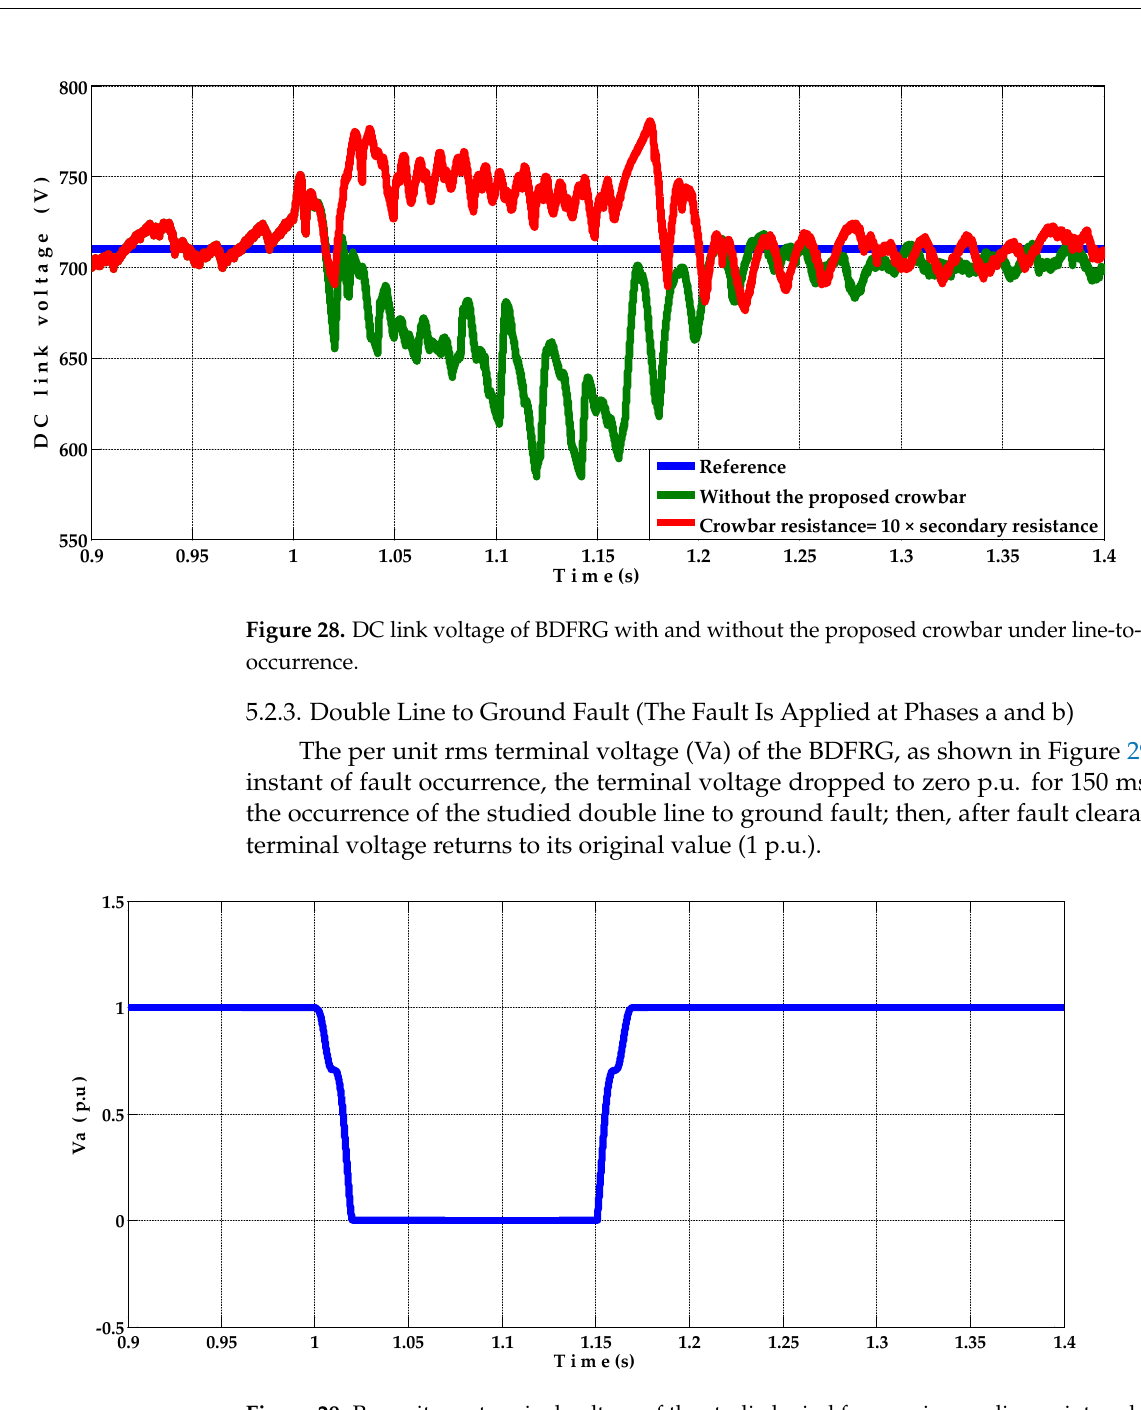
Figure 29. Per unit rms terminal voltage of the studied wind farm main coupling point under double line to ground fault occurrence.